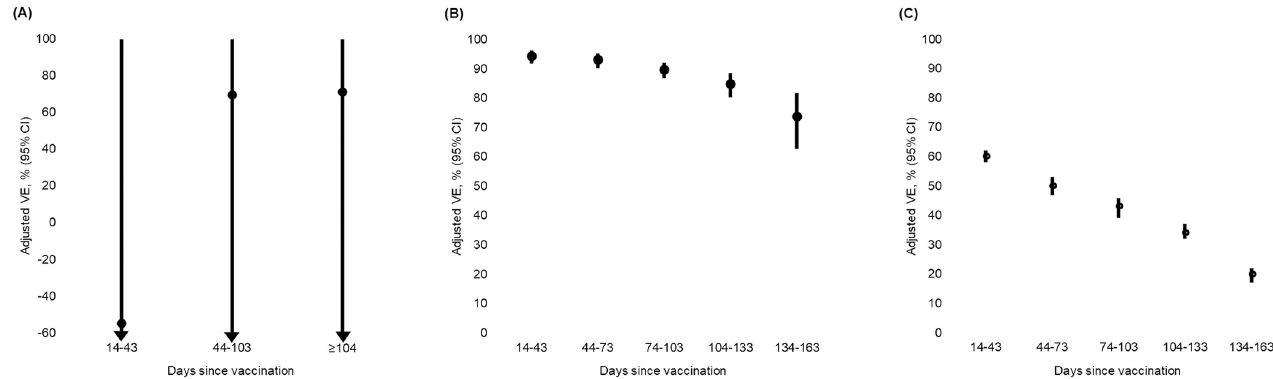
Fig 1. Adjusted VE against SARS-CoV-2 reinfection during periods of Alpha, Delta, or Omicron dominance. ( A ) Alpha variant (B.1.1.7), 20 February–15 June 2021. ( B ) Delta variant (B.1.617.2), 4 July–20 November 2021. ( C ) Omicron variant (B.1.1.529), 21 December 2021–31 January 2022. VE adjusted for age, sex, country of origin, comorbidity, staying at hospital, calendar time, and test incidence. CI AU : AnabbreviationlisthasbeencompiledforthoseusedinFig 1 : Pleaseverifythatallentriesarecorrect : , confidence interval; SARS-CoV-2, Severe Acute Respiratory Syndrome Coronavirus 2; VE, vaccine effectiveness.